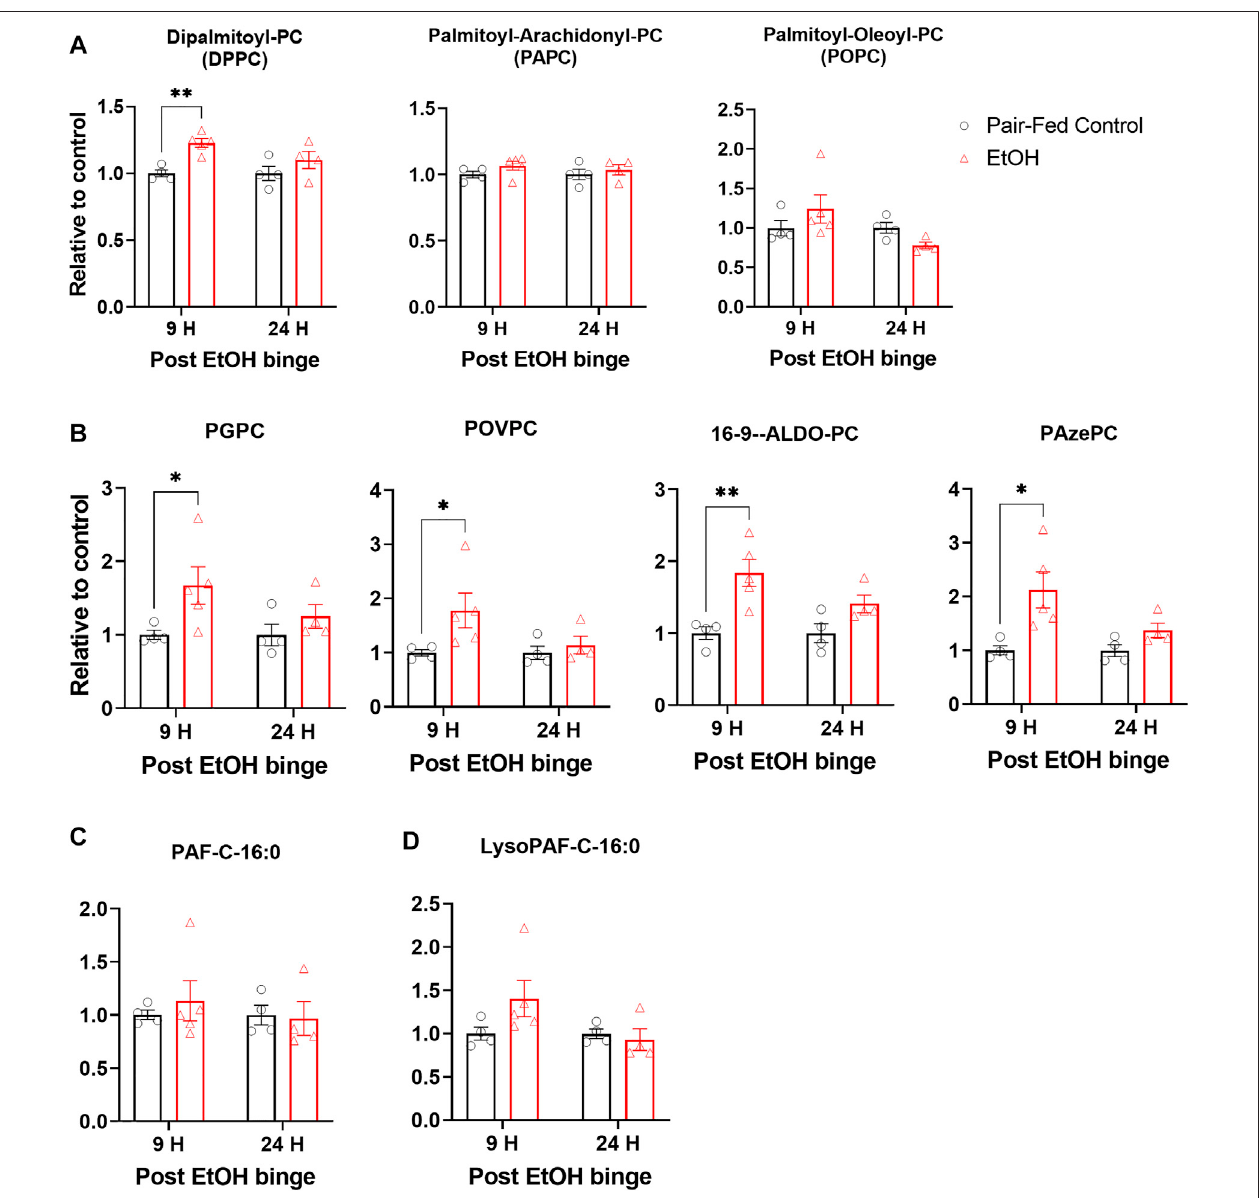
FIGURE 3 | Chronic and single binge ethanol feeding induced elevation of truncated oxidized phospholipids in muse lungs. (A) Levels of surfactant phospholipid dipalmitoylphosphatidylcholine(DPPC),andcellularphospholipidspalmitoyl-arachidonoylphosphatidylcholine(PAPC),palmitoyl-oleoylphosphatidylcholine(POPC)in lungs. (B) Levels of truncated oxidized phosphatidyl cholines, Palmitoyl Glutaryl Phosphatidyl Choline (PGPC), Palmitoyl Oxovaleryl Phosphatidyl Choline (POVPC), PalmitoylOxo-nonanoylPhosphatidylCholine(ALDO-PC), andPalmitoylAzelaoylPhosphatidylCholine(PAzePC). Platelet activatingfactorC16:0(PAFC16:0) (C)